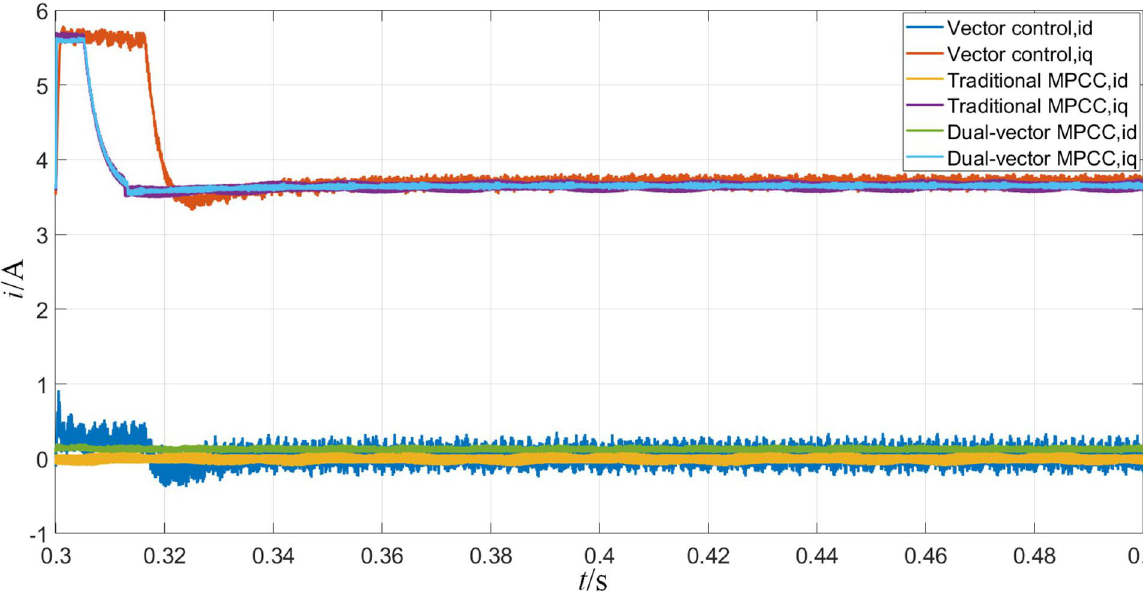
Fig 15. d-q axis current waveform when the given speed